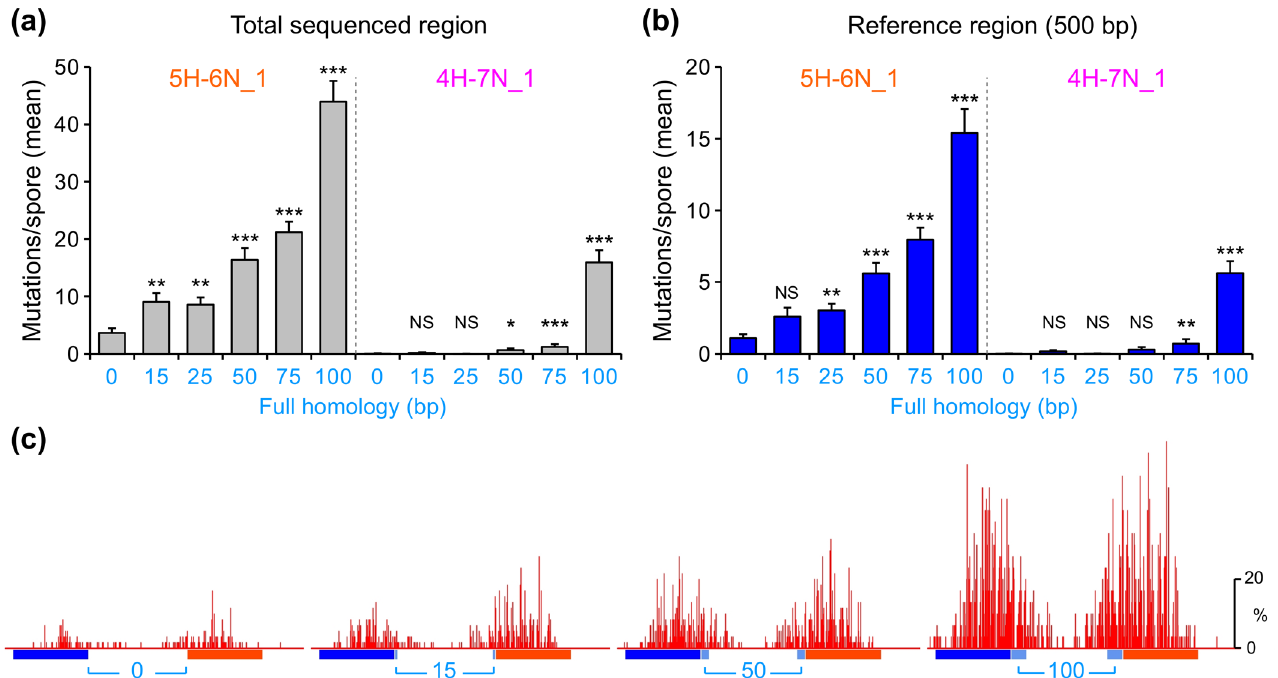
Fig 3. Short regions of perfect homology promote stronger mutation in combination with the 500-bp interspersed homology 5H-6N_1. (a) The mean number of RIP mutations (measured as in Fig 2C) for repeat constructs with 0 – 100 base-pairs of perfect homology adjacent to the interspersed homology 5H-6N_1 or 4H-7N_1. Data for the interspersed homology 4H-7N_1 are replotted from Fig 2C. (b) The mean number of RIP mutations detected across the 500-bp reference region for repeat constructs with 0 – 100 base-pairs of perfect homology adjacent to the interspersed homology 5H-6N_1 or 4H- 7N_1. (c) RIP mutation profiles for selected repeat constructs containing 0, 15, 50 and 100 base-pairs of perfect homology adjacent to the interspersed homology 5H-6N_1.